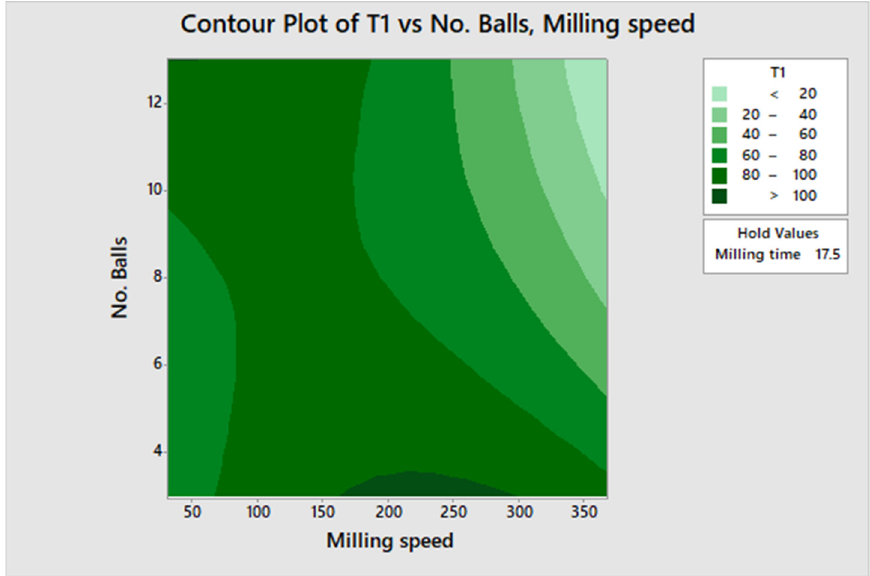
Figure 9. T1 vs. no. of balls– milling speed.